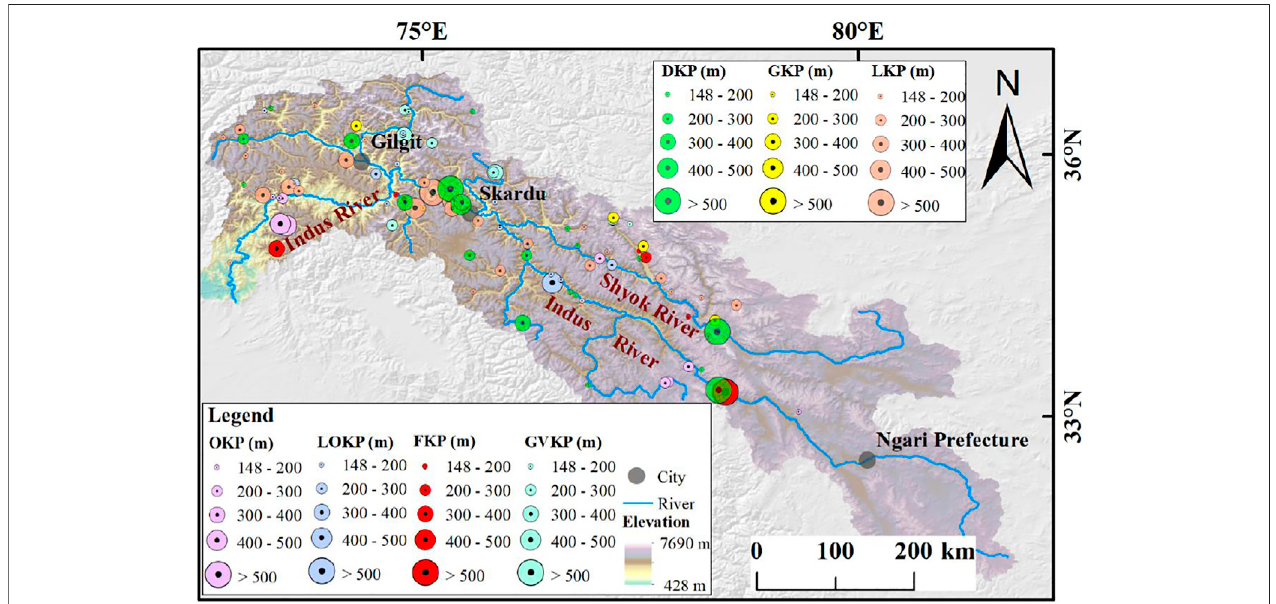
FIGURE 10 | Distribution of knickpoint types in the upper Indus